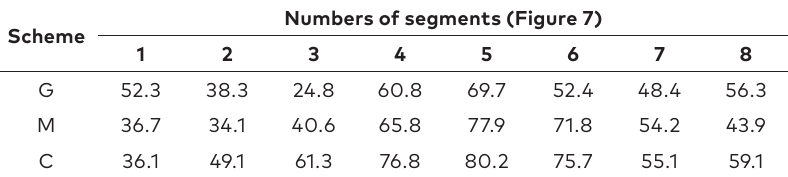
Table 4. Loads of bridge roadway as the terms of vector q ,